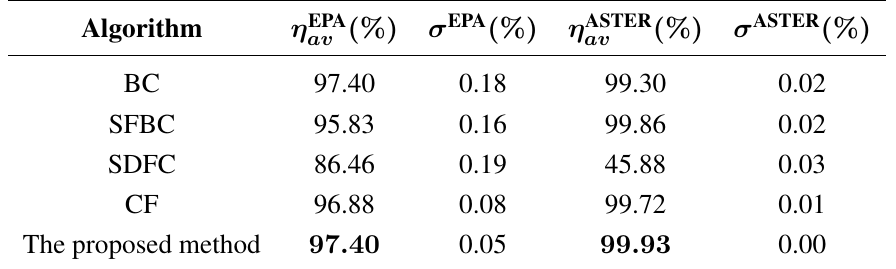
Table 5. Accuracy comparisons of different algorithms with the 2 datasets and SNR = 55